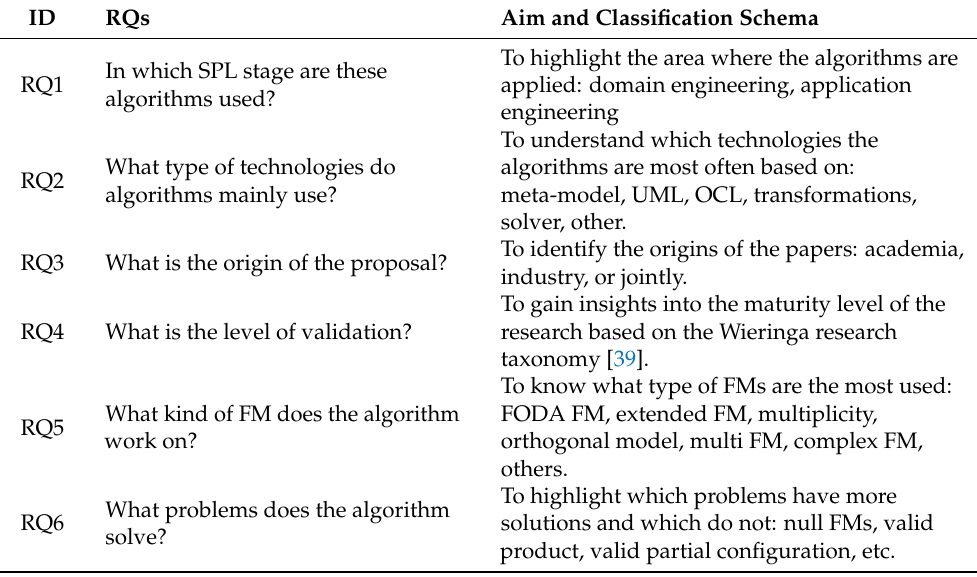
Table 5. RQs and